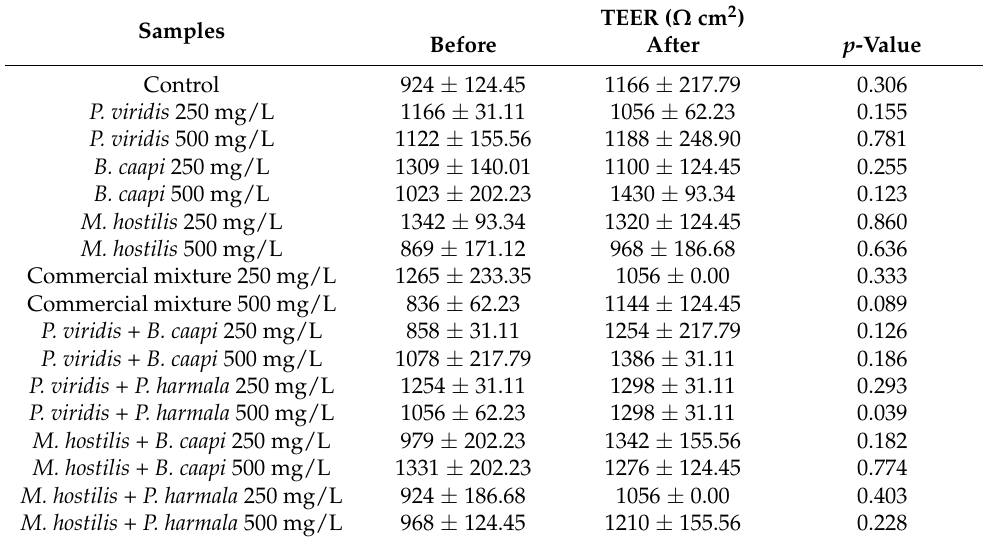
Table 4. TEER values obtained before and after incubation with the extracts. The values are expressed as mean ± SD. Statistically significant values were considered if p < 0.05. TEER ( Ω cm 2 ) Samples Before After p